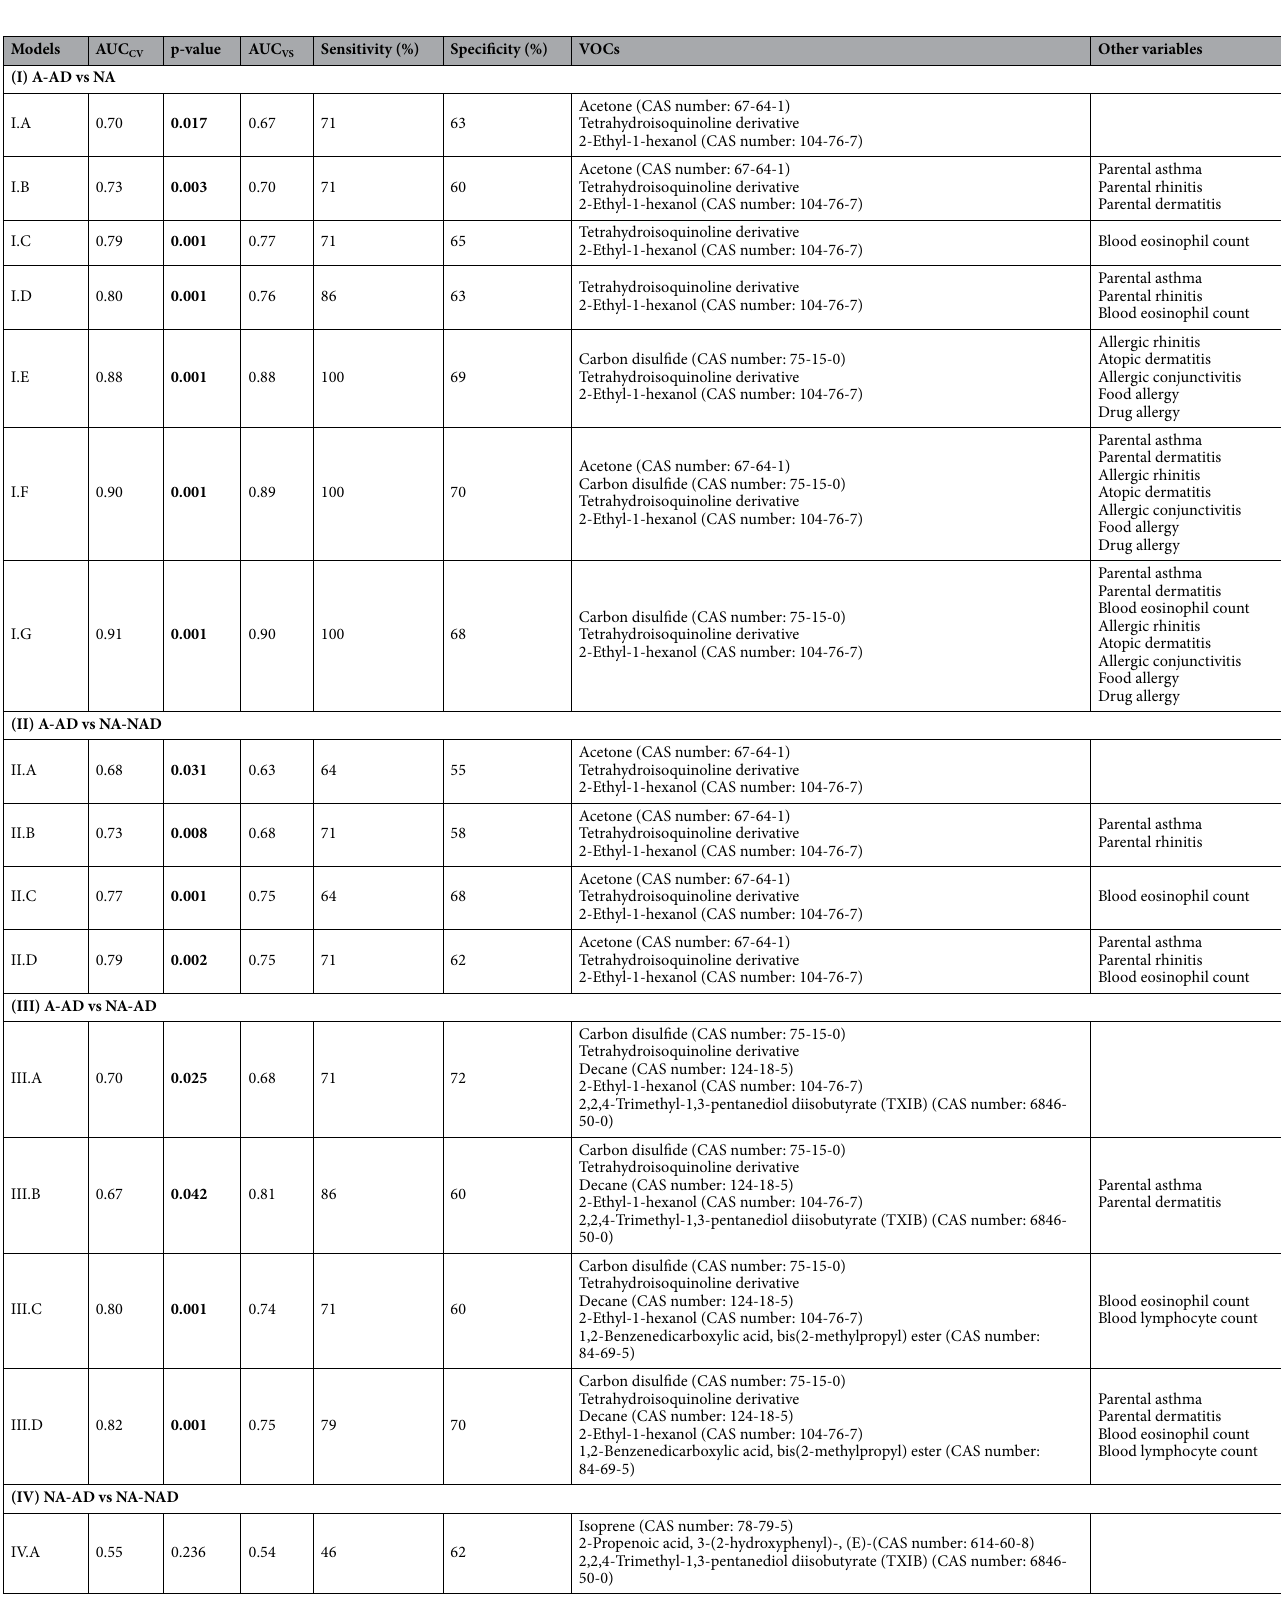
Table 3. Accuracy of constructed models and selected variables in each model (discriminant volatile organic compounds (VOCs) and other variables). A‑AD asthmatics with other coexisting atopic diseases; NA non- asthmatics; NA‑NAD non-asthmatics without atopic diseases; NA‑AD non-asthmatics with other atopic diseases; AUC area under the receiver operating characteristic curve; AUCcv AUC obtained by fivefold cross- validation; AUCvs AUC obtained by testing in validation